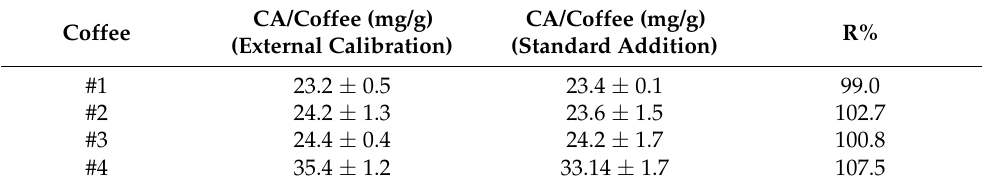
Table 2. Concentration values of CA expressed as CA/coffee mg/g computed by external calibration and by standard addition